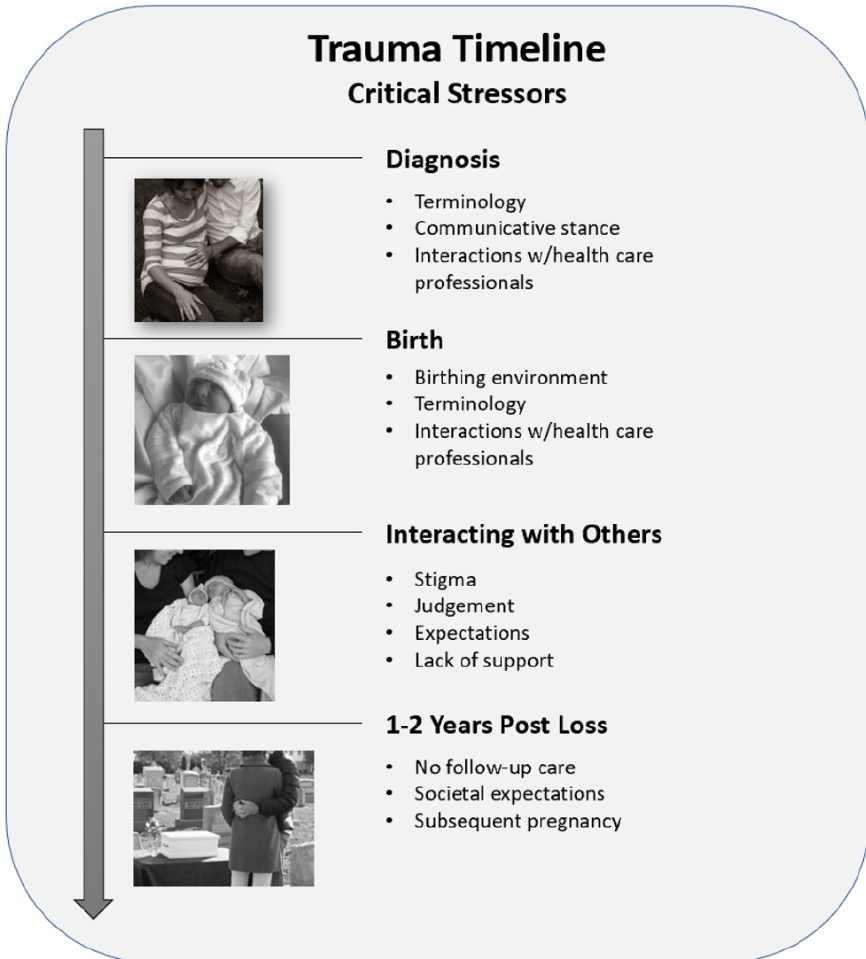
Figure 2. Trauma timeline and key milestones.